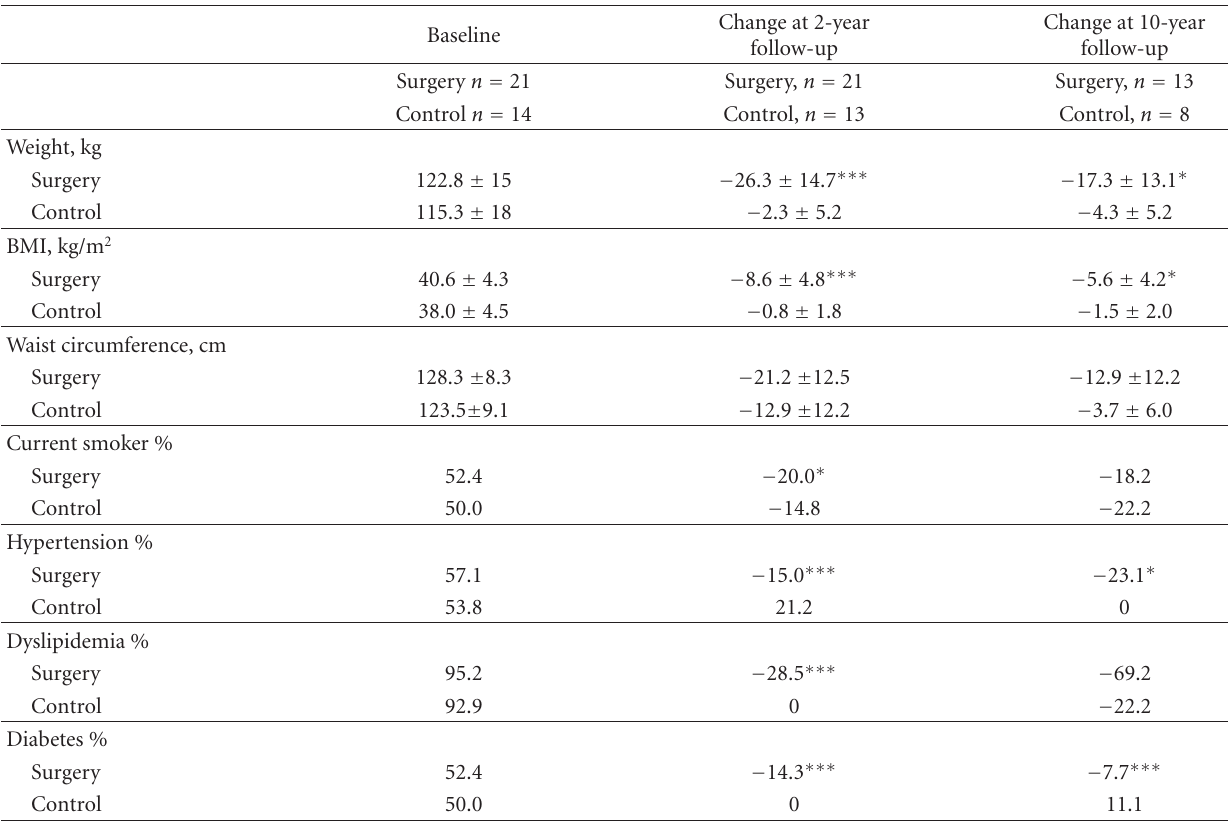
Table 1: Anthropometrics and prevalence of cardiovascular risk factors (%) in the surgery and control groups at baseline and changes in prevalence after 2 and 10 years of follow-up. Only the patients applicable for the certain timepoint are included in the statistical calculations. Change at 2-year Change at 10-year Baseline follow-up follow-up Surgery n = 21 Surgery, n = 21 Surgery, n =